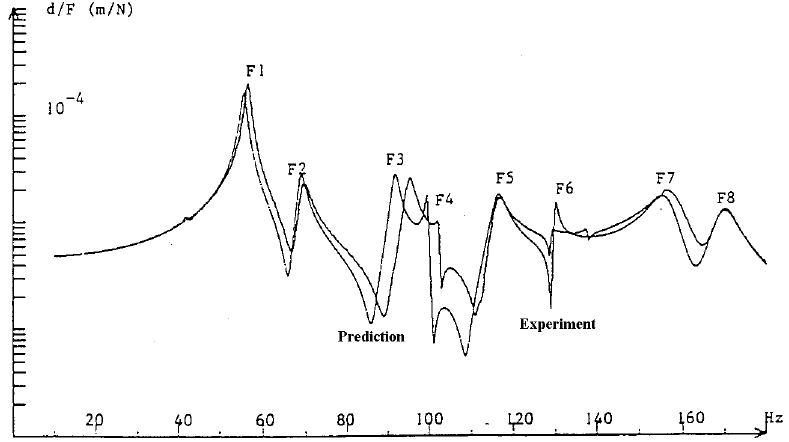
Fig. 6. Frequency response.